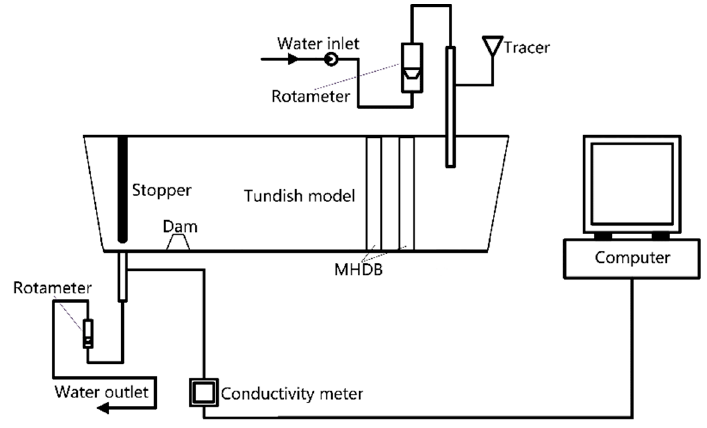
Figure 16. Water modeling experiment schematic.